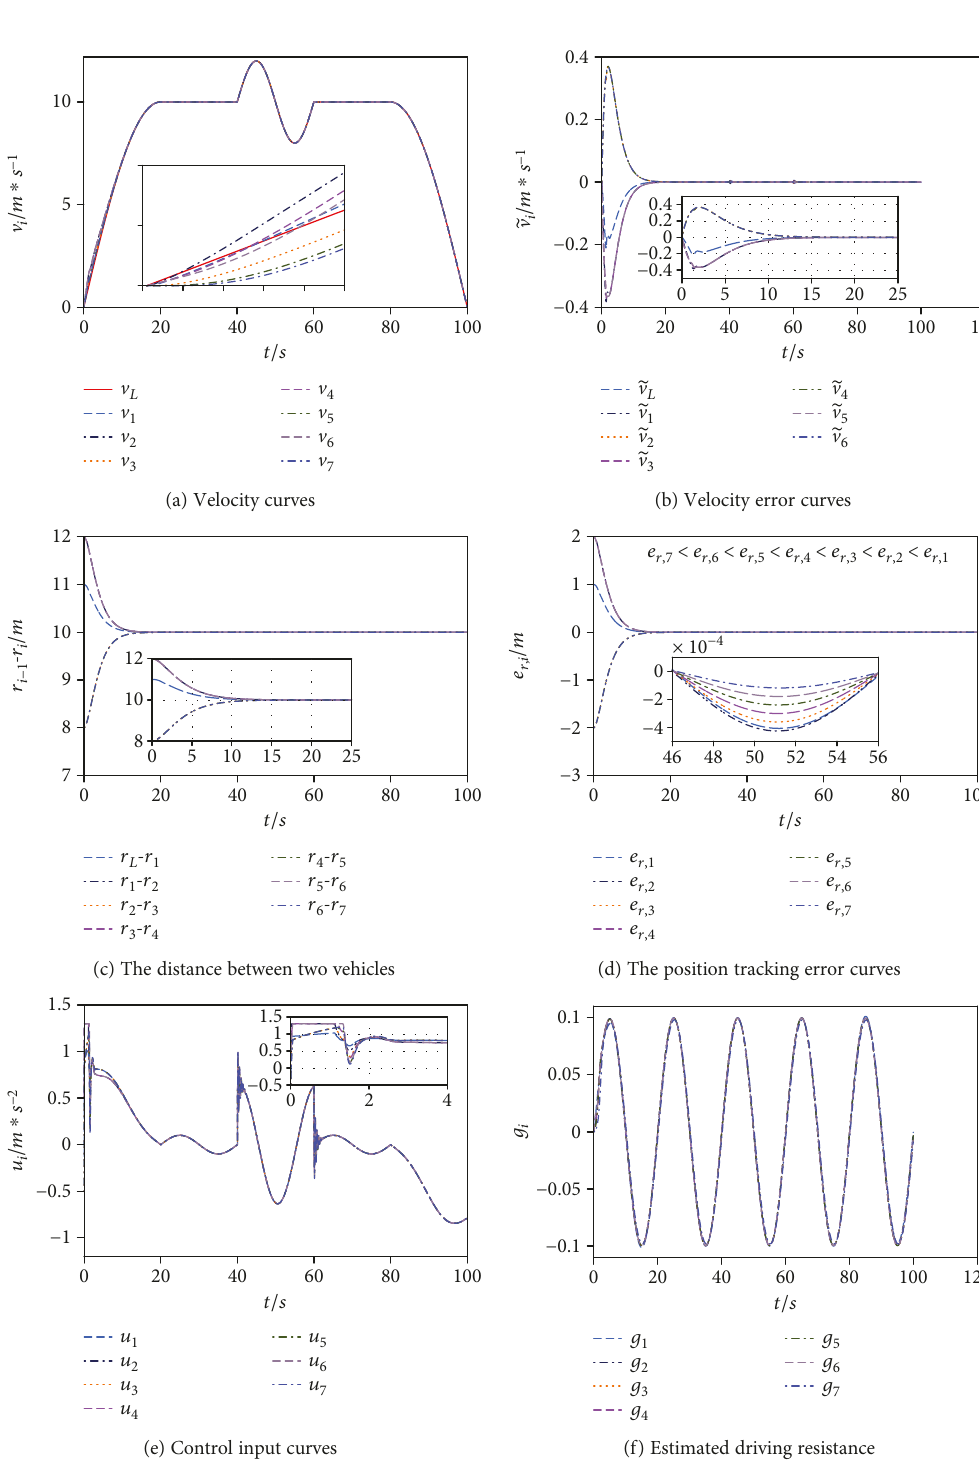
Figure 2: Vehicle platoon control with velocity constraints and input